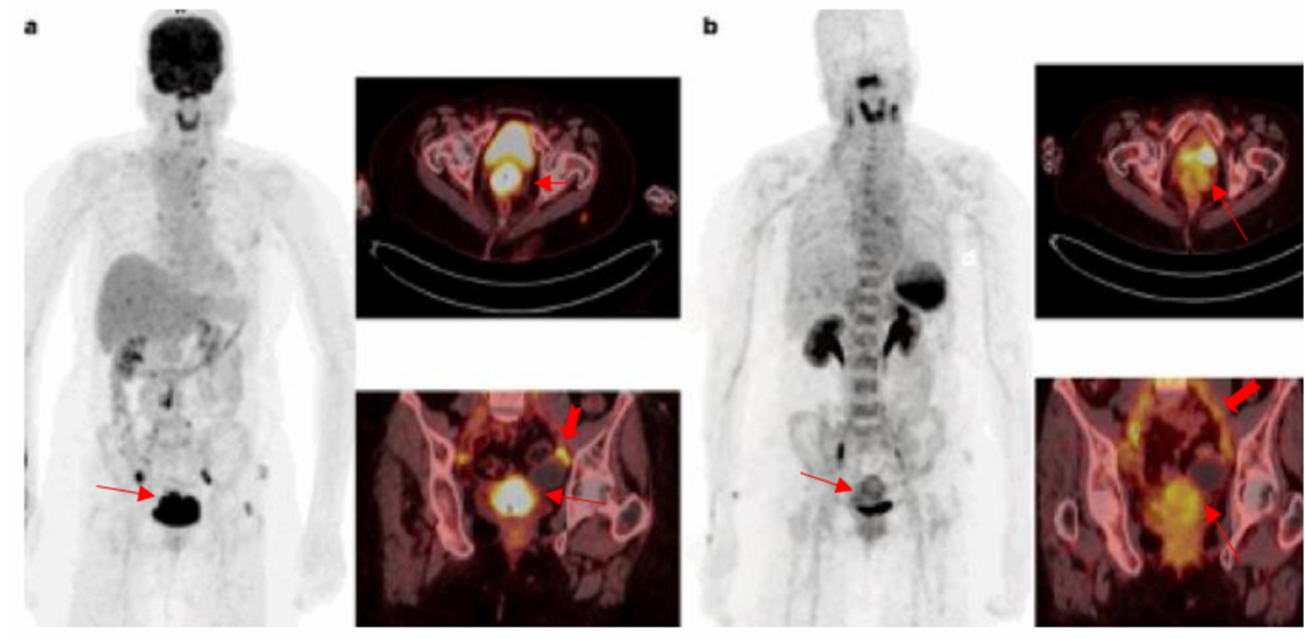
Figure 3. 18 F-FDG and 68 Ga-Pentixafor images of a 36-year-old female patent with squamous cell carcinoma of the cervix with intense uptake in the primary lesion and pelvic lymph node metastasis on 18 F-FDG ( a ). There is moderate heterogenous tracer accumulation on the 68 Ga-Pentixafor PET and very low uptake on the metastatic lymph node ( b